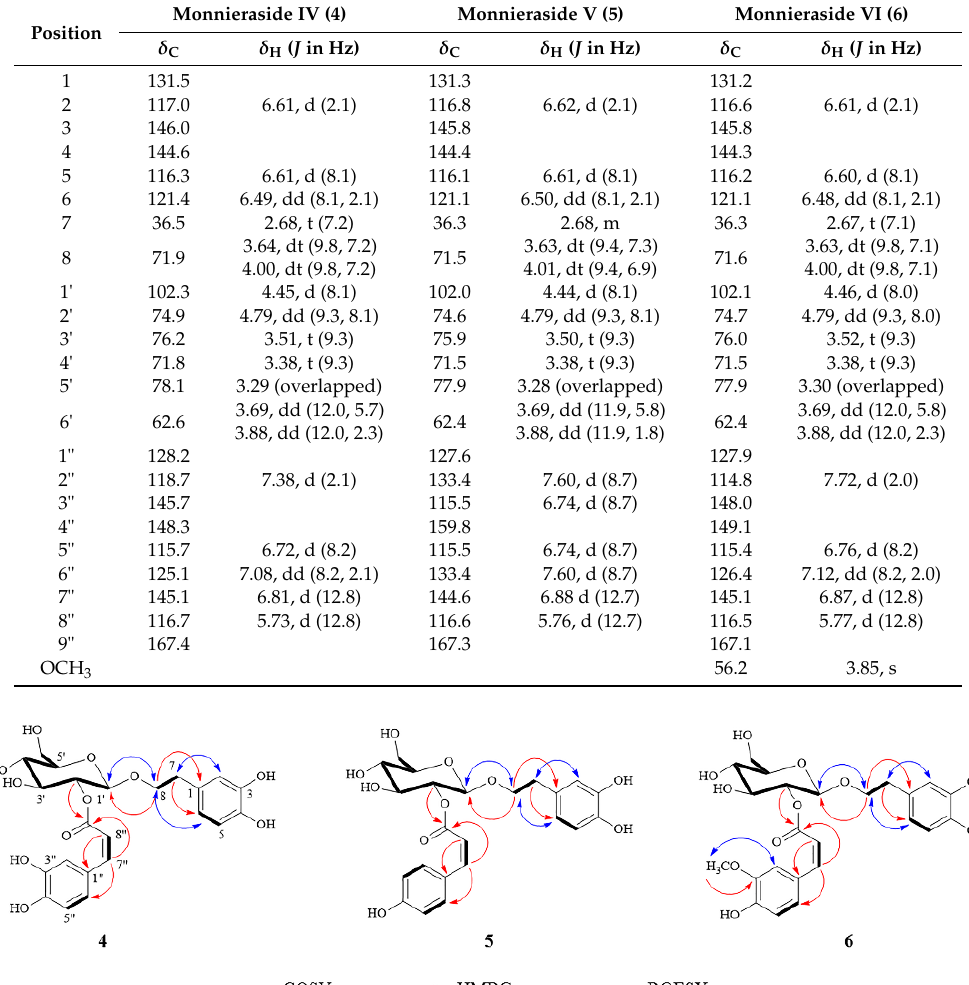
Table 2. 1 H- and 13 C-NMR (600 / 151 MHz, in CD 3 OD) of 4 – 6 .